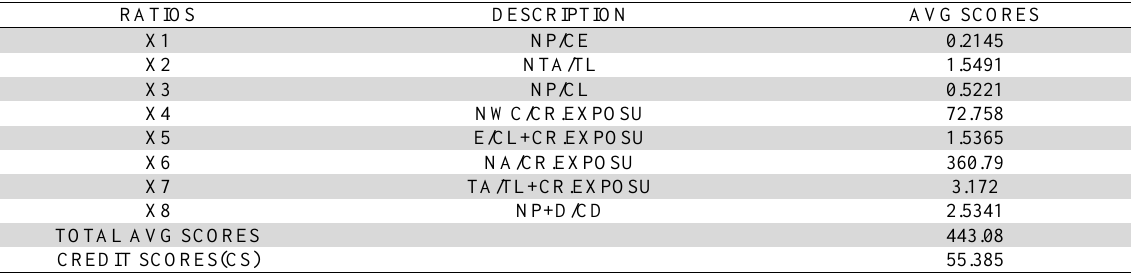
Risk Description Model –Ratio Measurement(Havells)